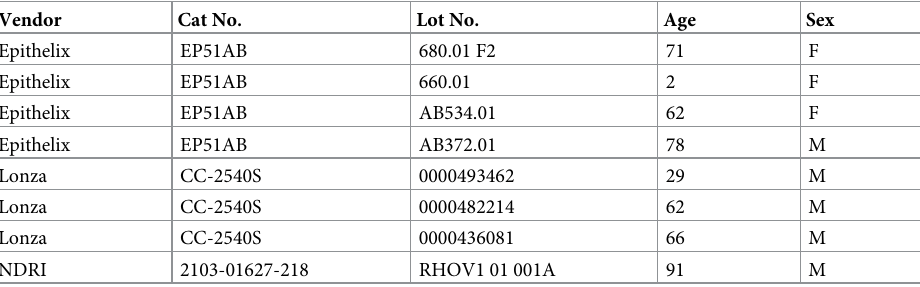
Table 1. Information on primary tissue-derived human bronchial epithelial cells. Vendor Cat No. Lot No. Age Sex Epithelix EP51AB 680.01 F2 71 F Epithelix EP51AB 660.01 2 F Epithelix EP51AB AB534.01 62 F Epithelix EP51AB AB372.01 78 M Lonza CC-2540S 0000493462 29 M Lonza CC-2540S 0000482214 62 M Lonza CC-2540S 0000436081 66 M NDRI 2103-01627-218 RHOV1 01 001A 91